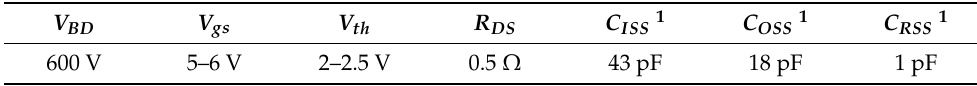
Table 1. DUT preliminary electrical specifications.